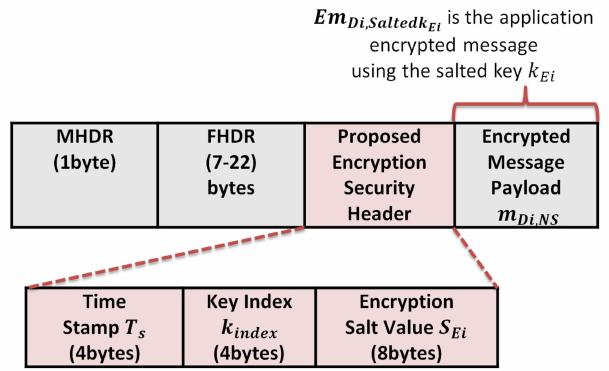
Figure 15. The proposed protocol encrypted message